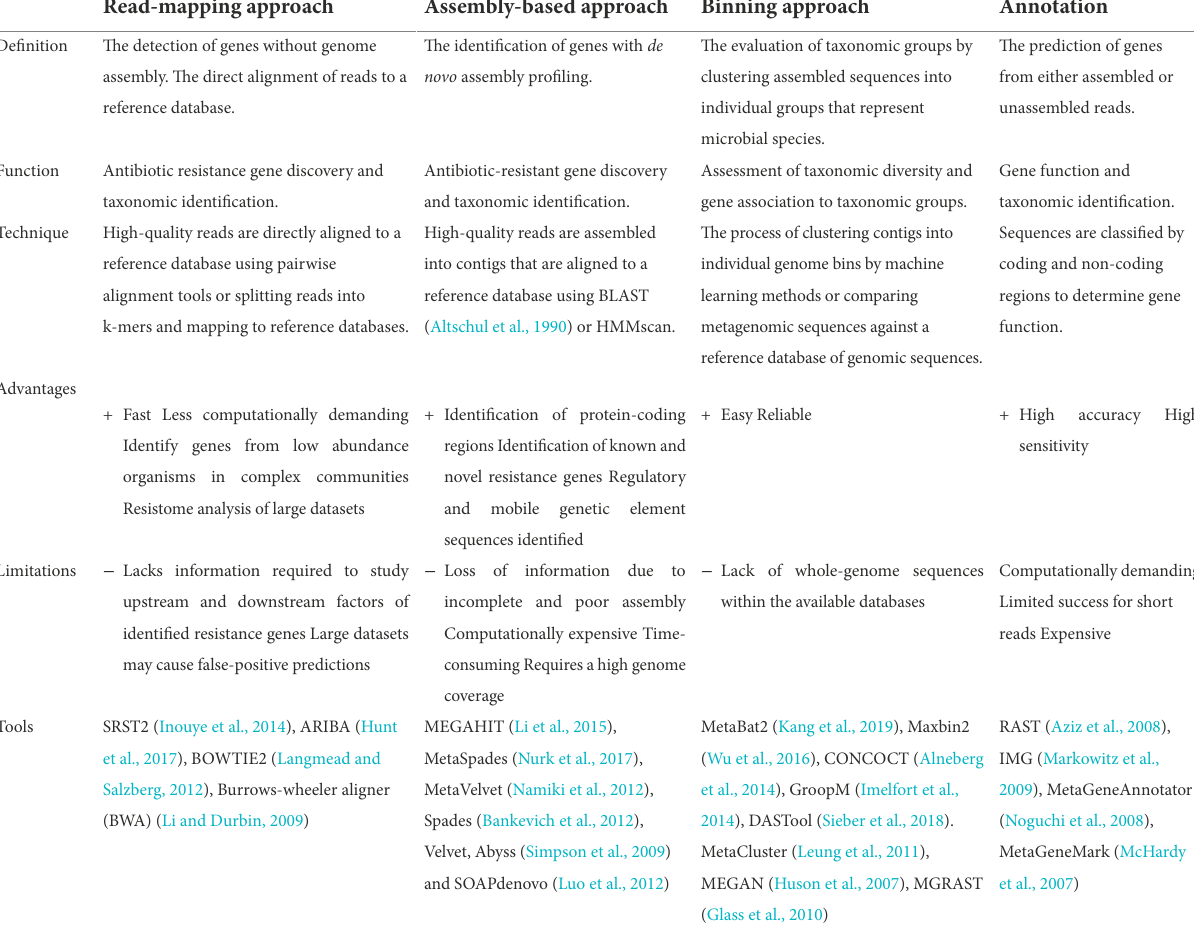
TABLE 4 Various bioinformatics approaches for the prediction of AMR and